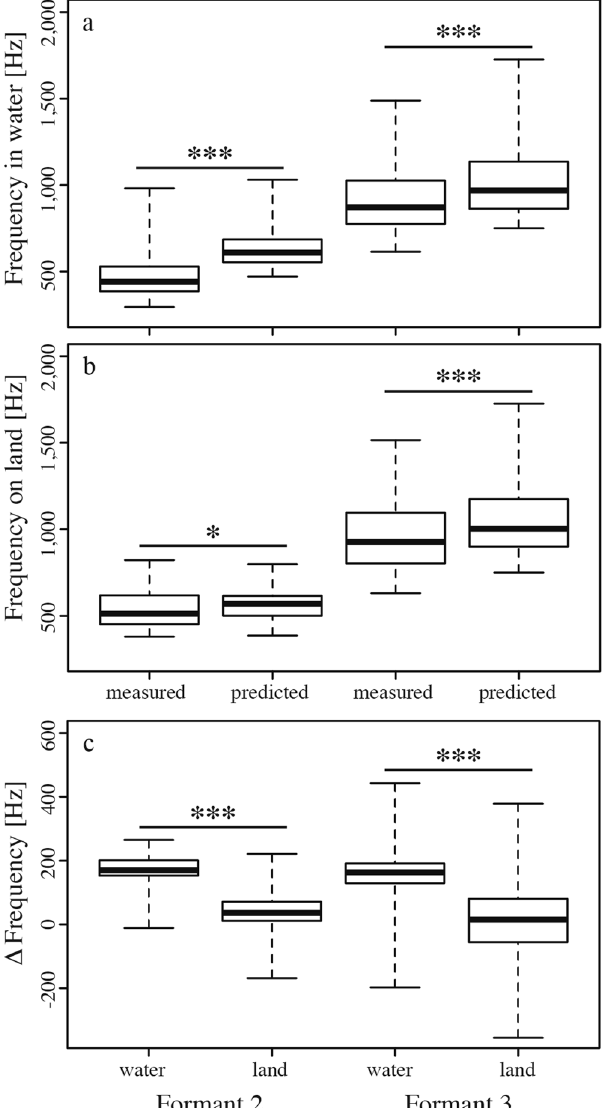
Figure 4. The theoretically expected frequencies of F2 and F3, calculated based on measured F1, were higher than the measured F2 and F3 both in water ( a ) and on land ( b ). The differences between the measured and the predicted formants ( ∆ Frequency) were lower on land than in water for both F2 and F3 ( c ) ( * P ≤ 0.05; ** P ≤ 0.01; *** P ≤ 0.001), indicating that vocal tract configuration is closer to a uniform tube during land- based